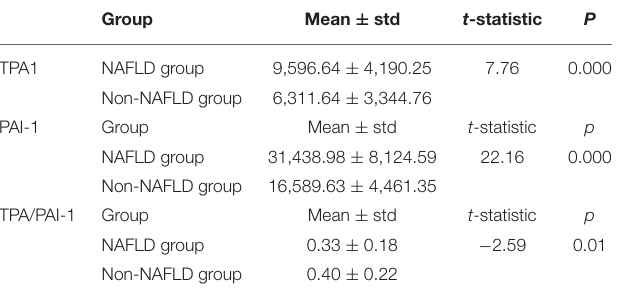
TABLE 2 | Comparison of TPA1, PAI-1 between the NAFLD and non-NAFLD patients.